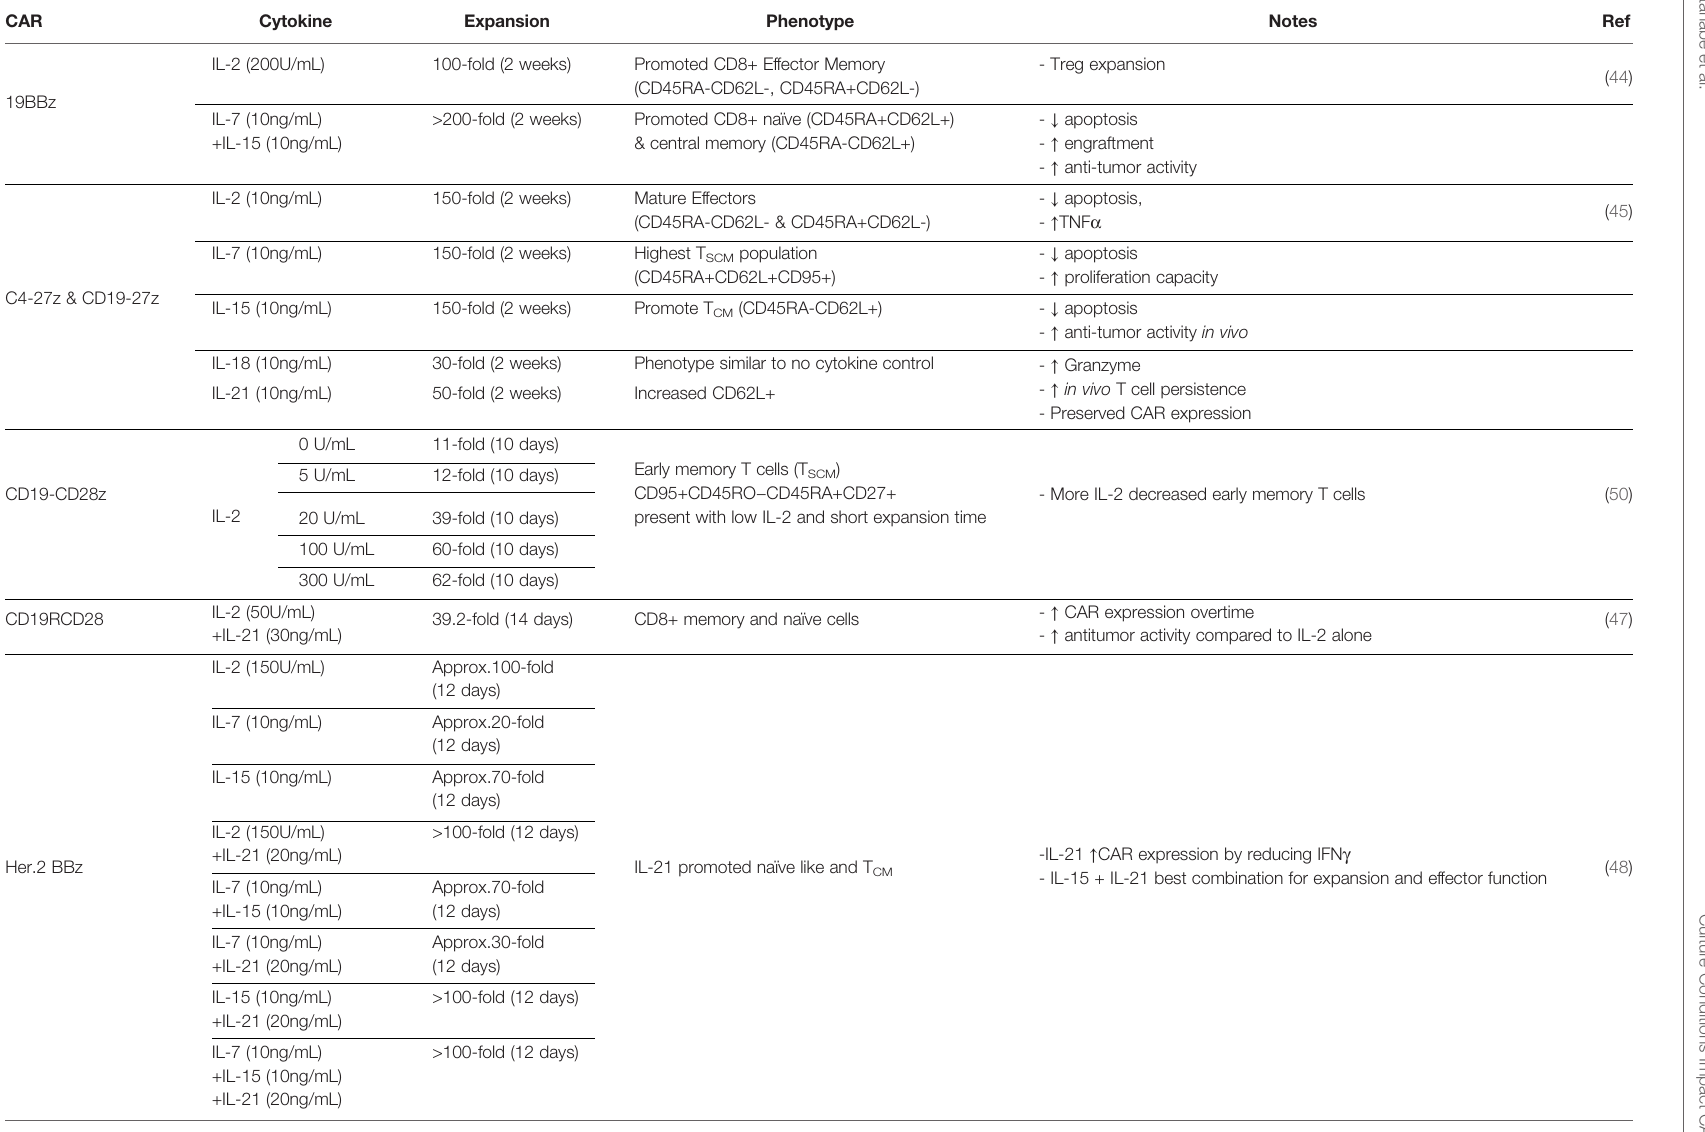
TABLE 3 | Impact of exogenous cytokines on CAR T cell expansion and